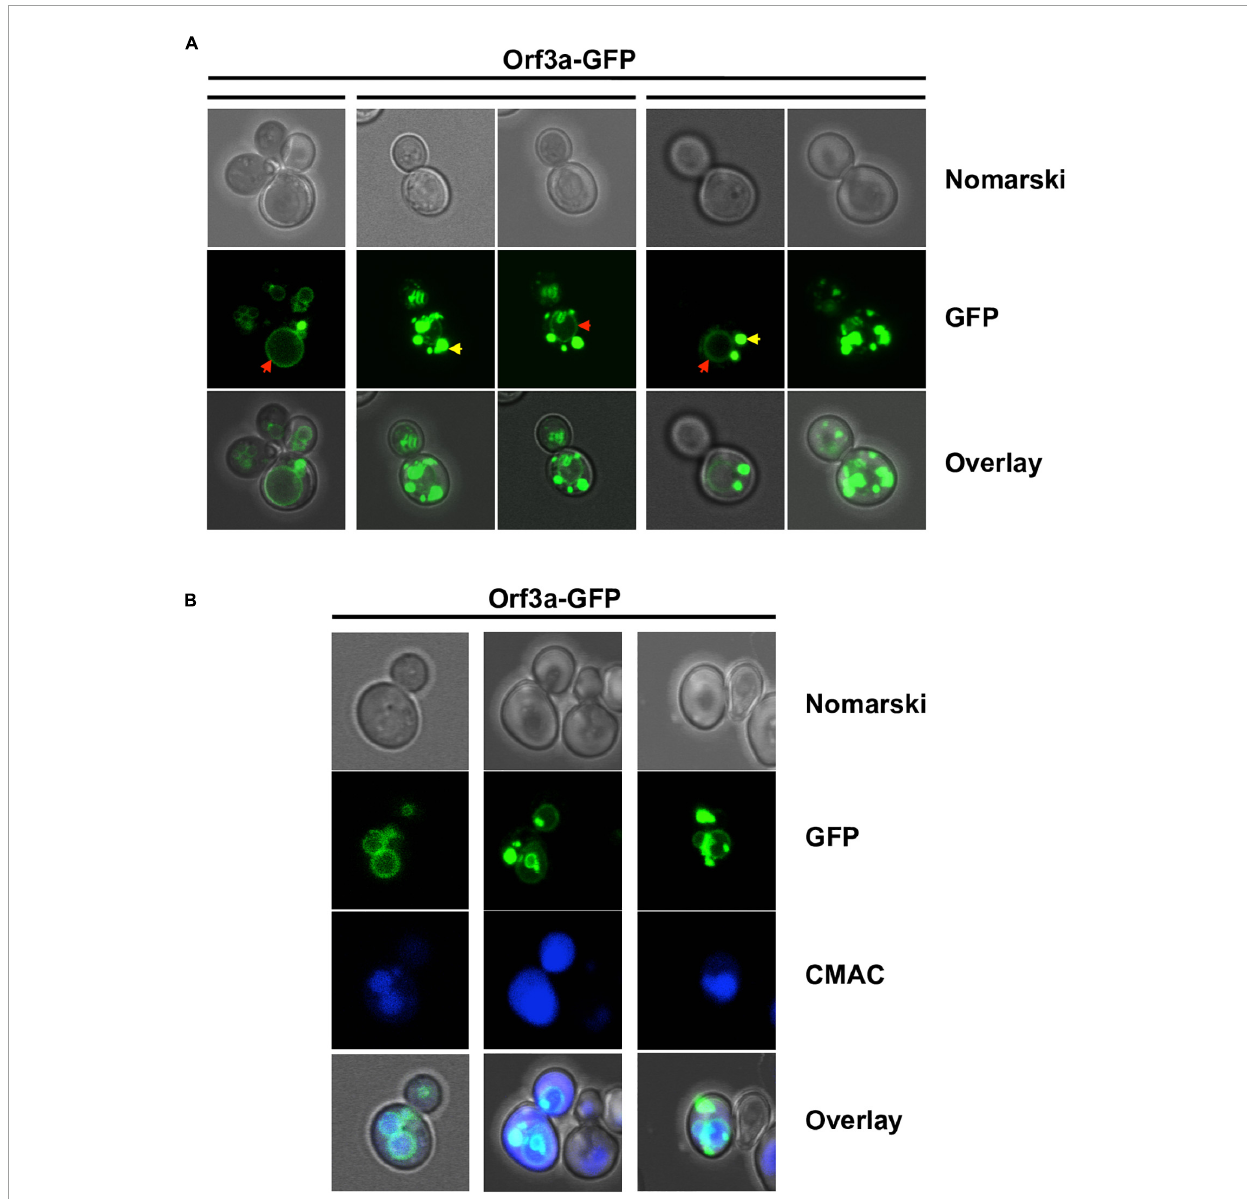
FIGURE2 Severe acute respiratory syndrome coronavirus-2 (SARS-CoV-2) ORF3a localizes to the vacuolar membrane in yeast cells. ORF3a-GFP was constitutively overexpressed in yeast wild type cells from high copy plasmids and visualized by confocal fluorescence microscopy. (A) Representative examples of ORF3a-GFP intracellular distribution. Different z-stacks are represented as indicated. Red arrows mark an apparent vacuolar envelope localization, yellow arrows mark a localization to round deposits for ORF3a. (B) ORF3a-GFP colocalization with the vacuolar